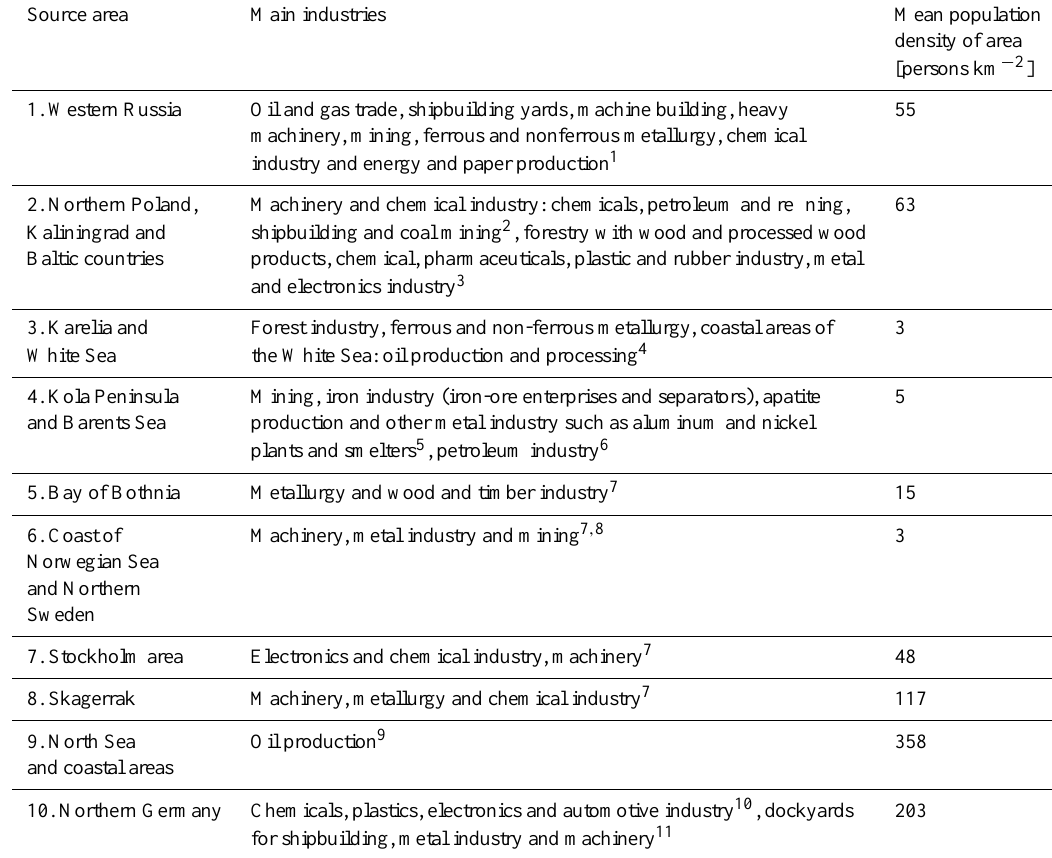
Table A1. Main industries of source